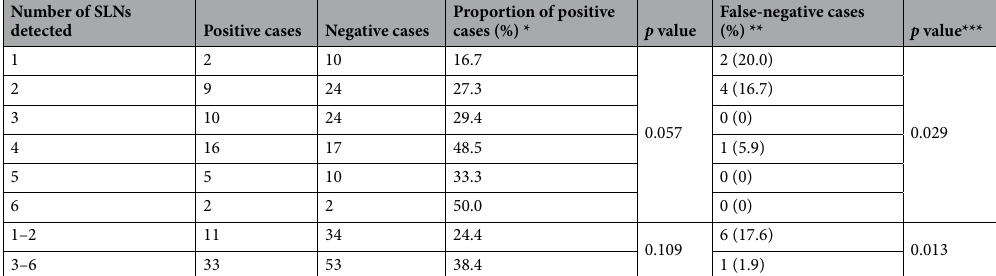
Table 2. The number of detected sentinel lymph nodes (SLNs) per case with the corresponding number of negative SLNs cases, number of neck recurrences, and false-negative cases. *Positive case/(positive cases + negative cases). **False-negative cases/negative cases. ***False-negative cases and negative cases were used as categories of a 2 × 2 contingency table. The trend of proportion was tested using the Cochran-Armitage test. Dichotomous SLN number and proportions of negative and false-negative values were tested using the chi-square test and Fisher’s exact test.